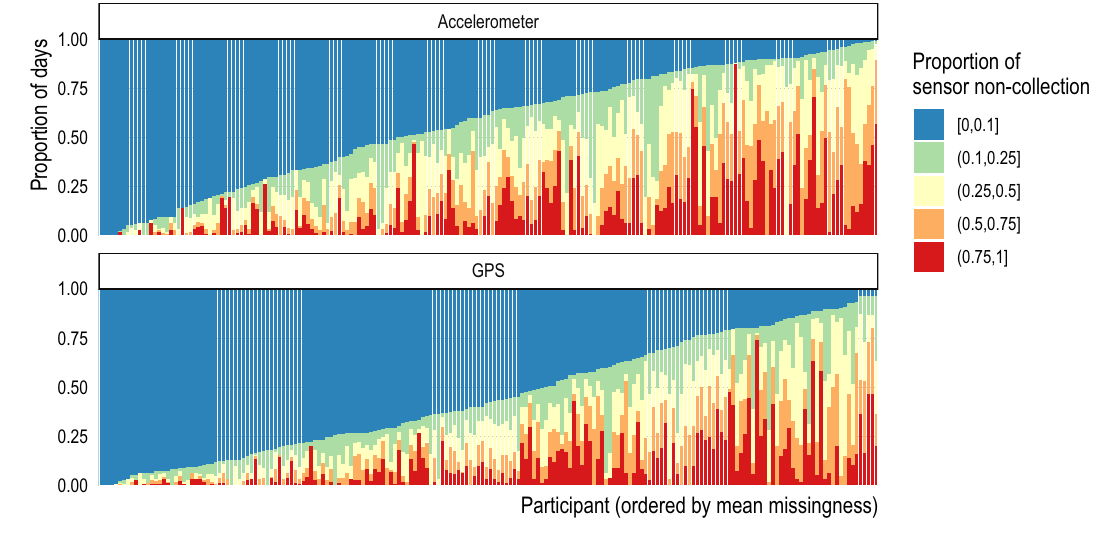
Figure 2. Proportion of missing observations by participant. Each vertical bar represents the proportion of missingness (color) for a single participant for accelerometer (top) and GPS (bottom) data. Participants are ordered by the average proportion of missingness. Follow-up was pre-specified in each study protocol based on time (i.e., not by the amount of data collected per subject).